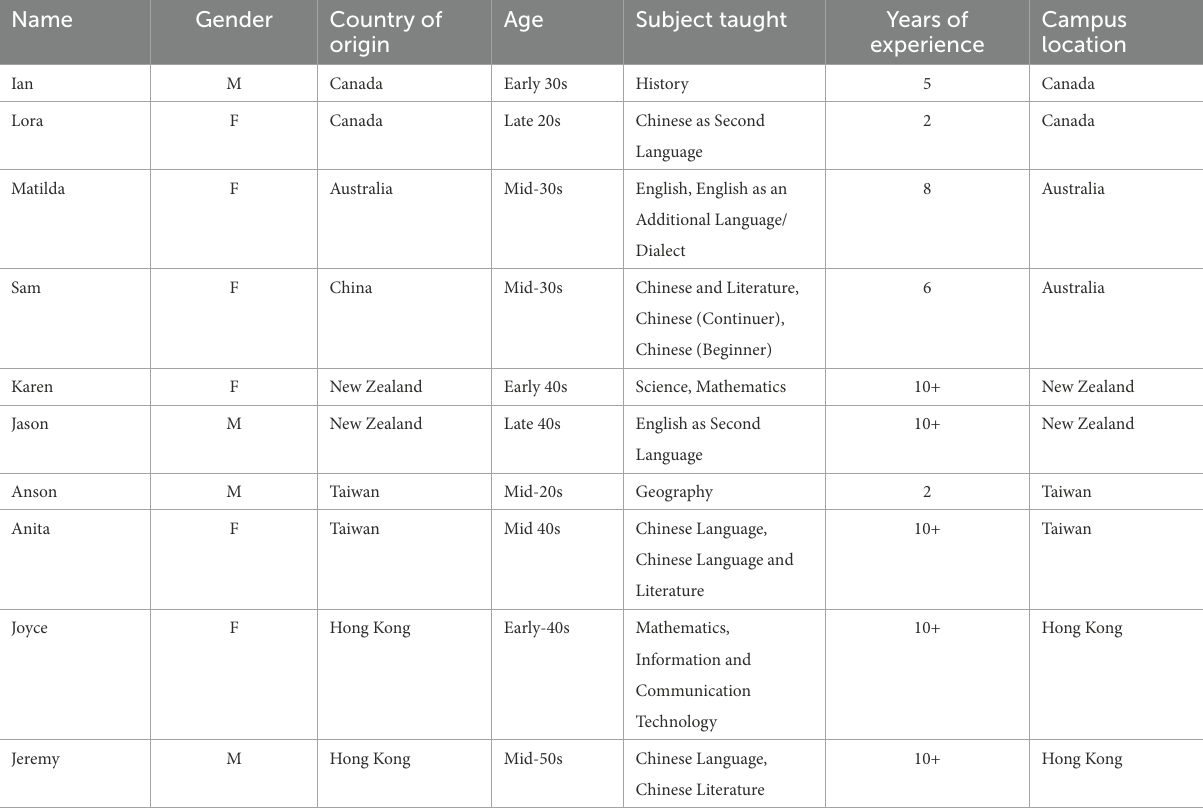
TABLE 1 Demography of the participants.